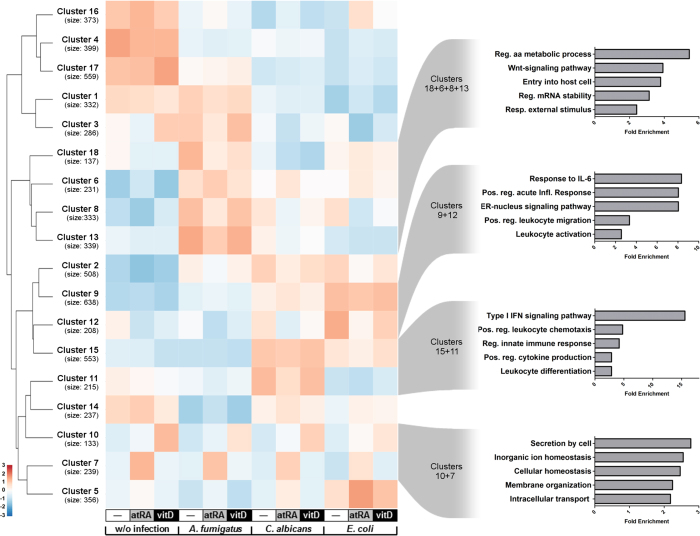
Heatmap of K-means clustering of DEGs and subsequent GO enrichment analysis.K-means clustering was performed on variance-stabilized read counts to build a heatmap for the 6076 differentially expressed protein-coding genes (adjusted p-value < 0.05). A priori, the model-based optimal number of K = 18 was determined. The clustering of the rows is based on euclidean distance. The colors in the map represent row-scaled expression levels: blue indicates the lowest expression, white indicates intermediate expression, and red indicates the highest expression. Selected clusters were analysed with regard to their biological function by GO enrichment analysis. Most enriched GO categories are shown for representative groups of clusters displaying their fold enrichment.